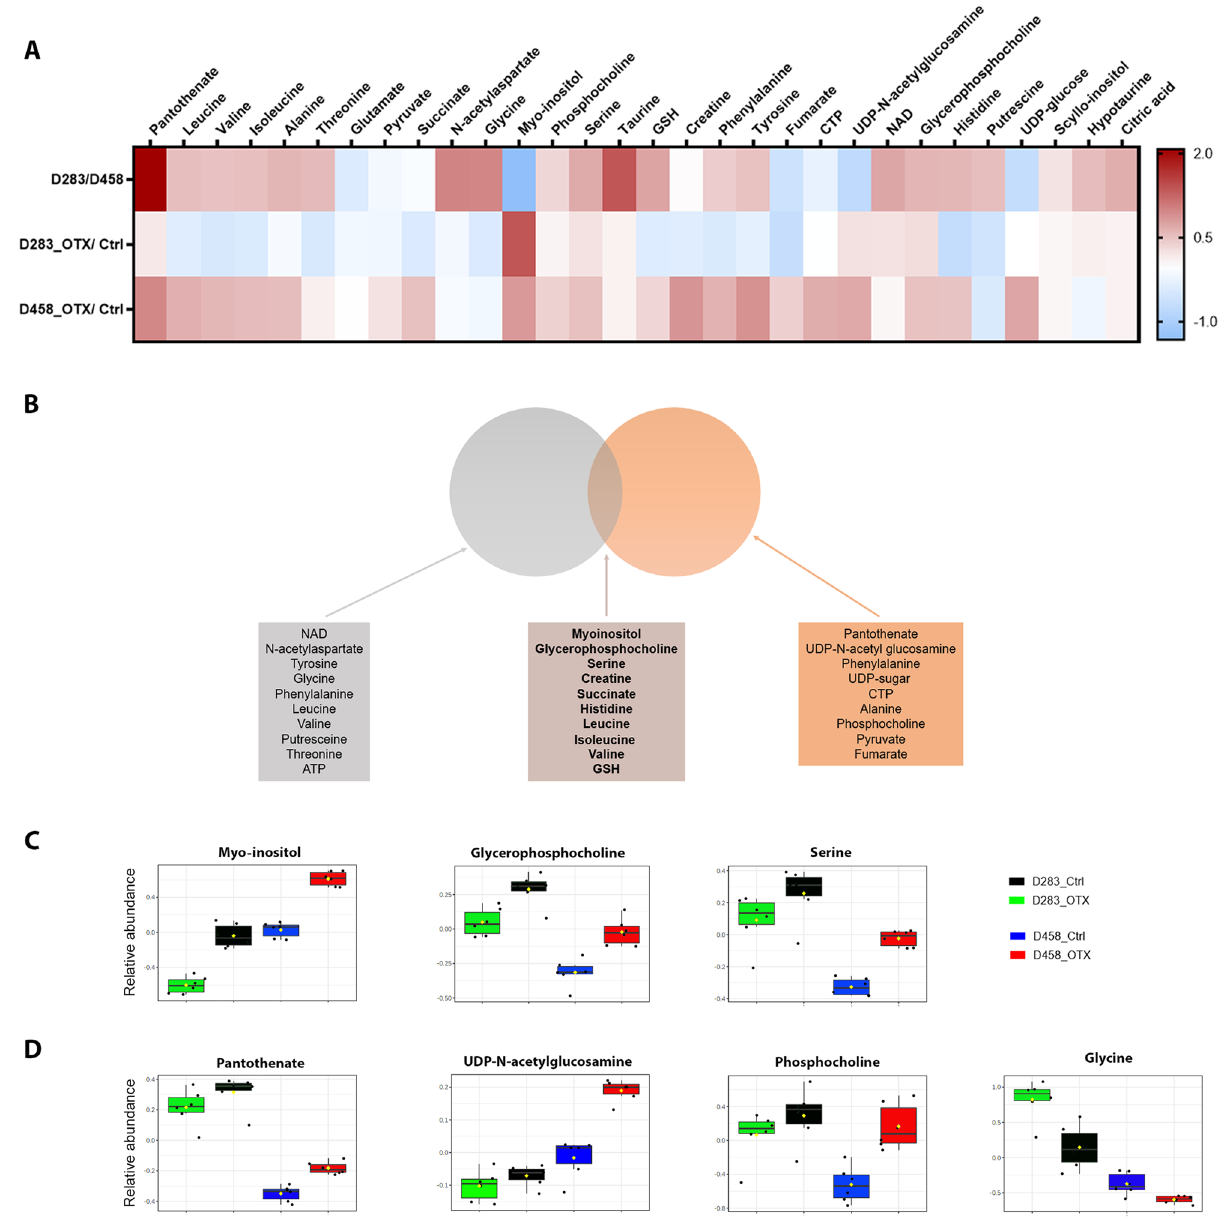
Figure 4. ( A ) Heatmap showing metabolite quantification (Log2 fold change values) in D283 versus D458 cell lines, D283_OTX versus D283_Ctrl and D458_OTX versus D458_Ctrl. Metabolites were quantified with MATLAB, according to intensity of metabolite signal in the 1 H NMR spectrum and calculated using an internal standard (n = 6). ( B,C ) Boxes depicting metabolites commonly deregulated in D283_OTX versus D283_Ctrl and D458_OTX versus D458_Ctrl and statistically significant in both the comparisons ( B ) or at least in one of them ( C ). Statistical analysis has been performed using one way-ANOVA (see Supplementary Table